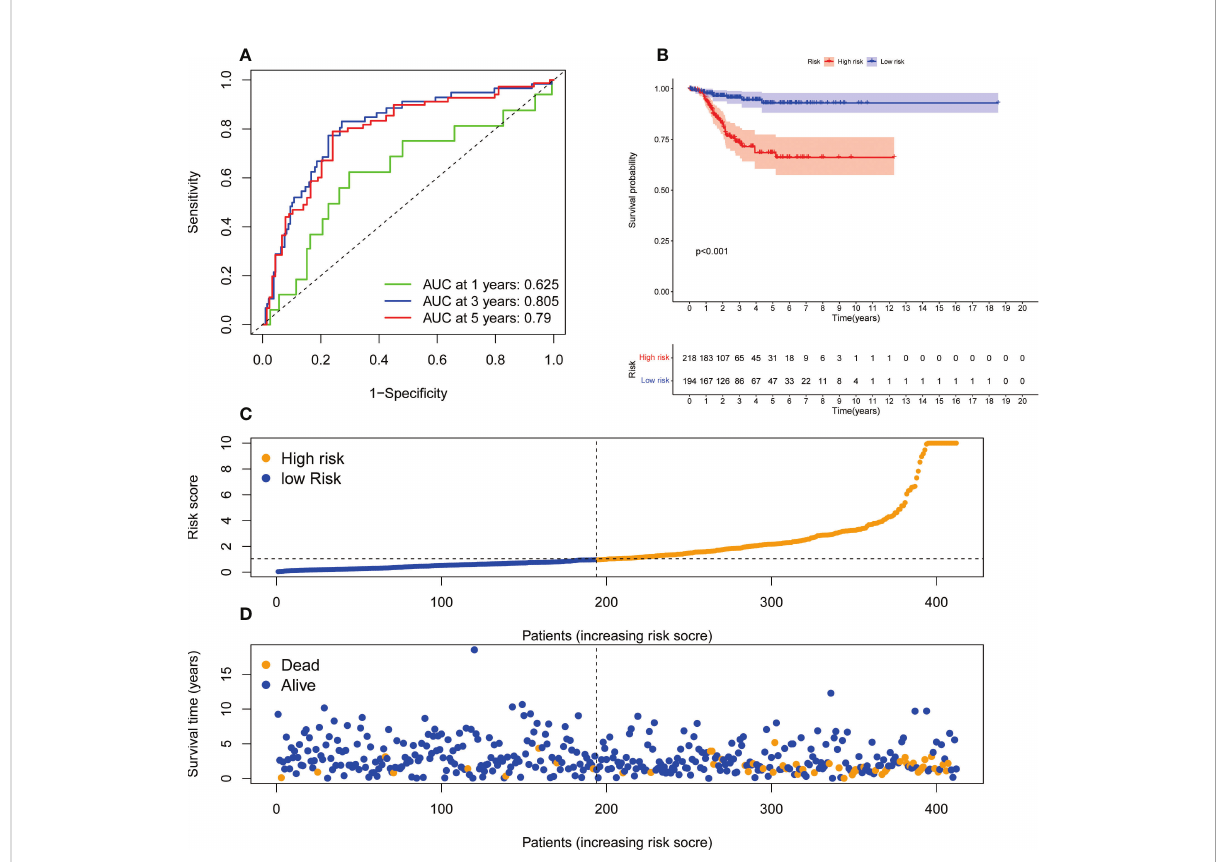
FIGURE 8 The predictive value of endoplasmic reticulum stress -related lncRNA signature in DFS. (A) ROC curve at 1-, 3-, and 5-year survival based on TCGA-UCEC data. (B) Kaplan-Meier survival curve based on TCGA-UCEC data. (C) The number of dead and alive patients with different risk scores. Blue represents the number of alive, and yellow represents the number of dead. (D) The distribution of the risk score in UCEC patients. DFS, disease-free survival; ROC, receiver operating characteristic; AUC, area under the